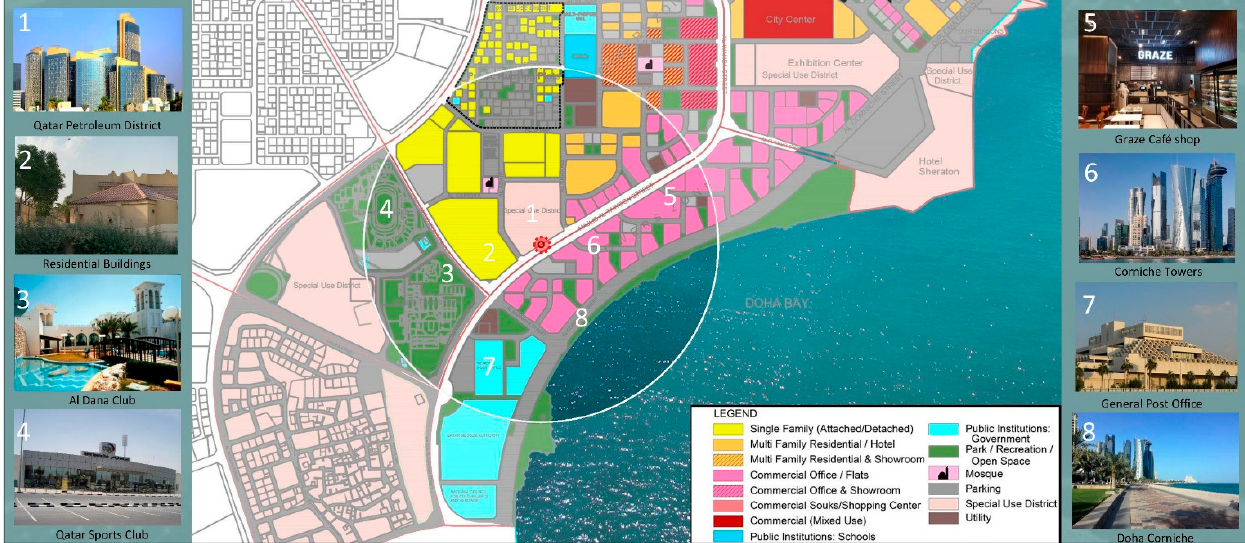
Figure 10. Land uses in the study area and photos of adjacent buildings (Source: the Authors).